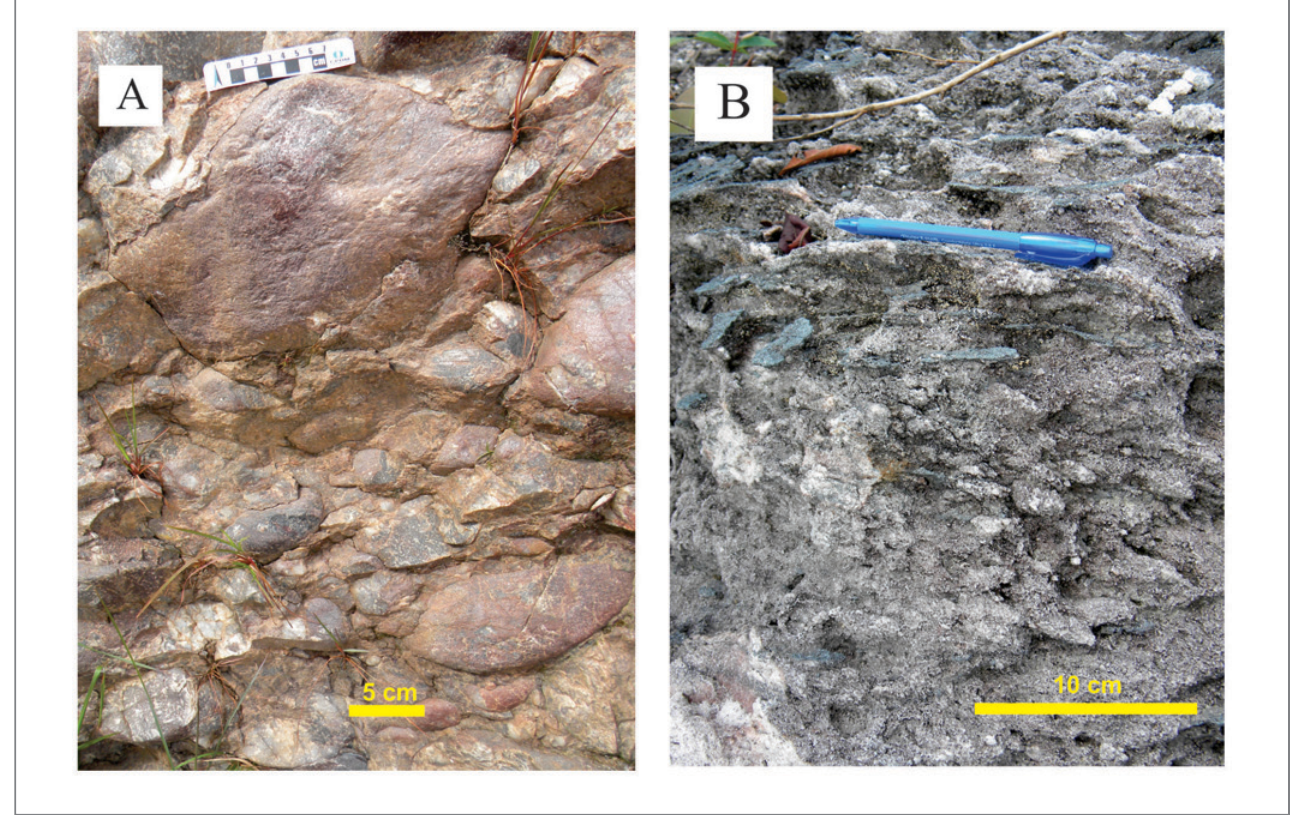
Figure 6 - Mesoscopic aspects of rocks of the Castelo dos Sonhos Formation A) Polymictic metaconglomerate with B) Medium-grained gray metasandstone, rich in magnetite, with undulated S0 striking